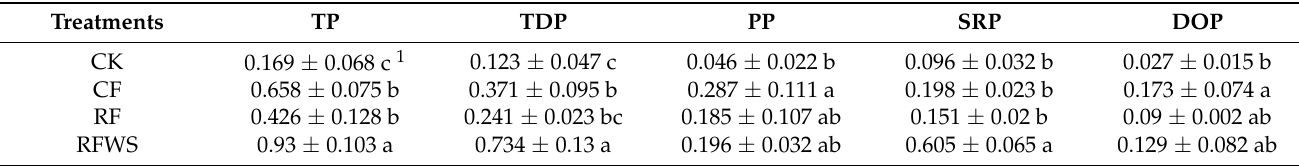
Table 2. The average concentration of different forms of P in the overlying water (mg L − 1